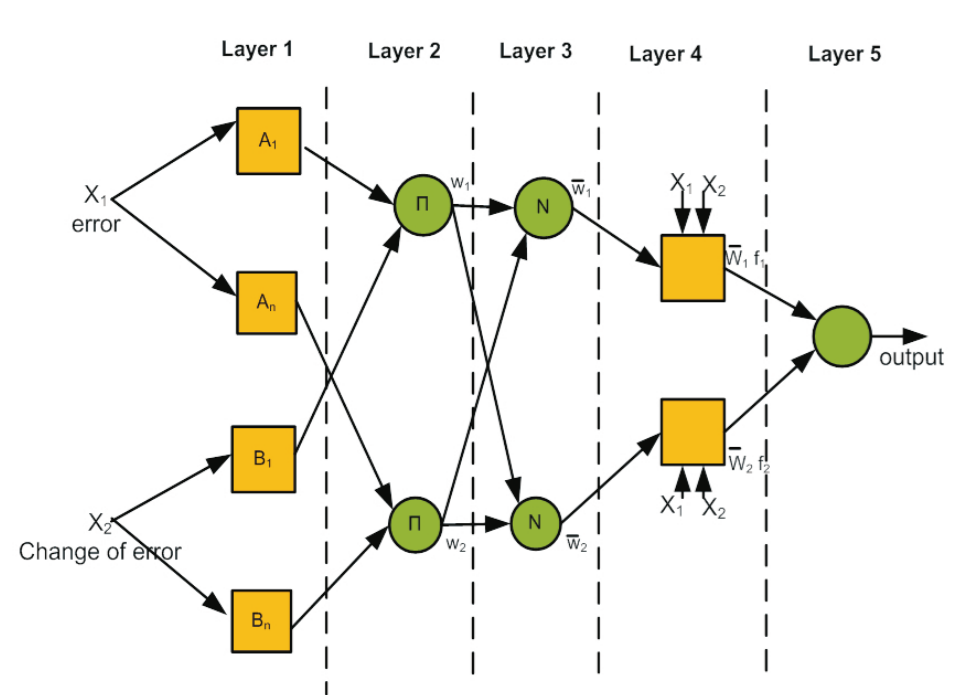
Figure 3: A Five layer ANFIS